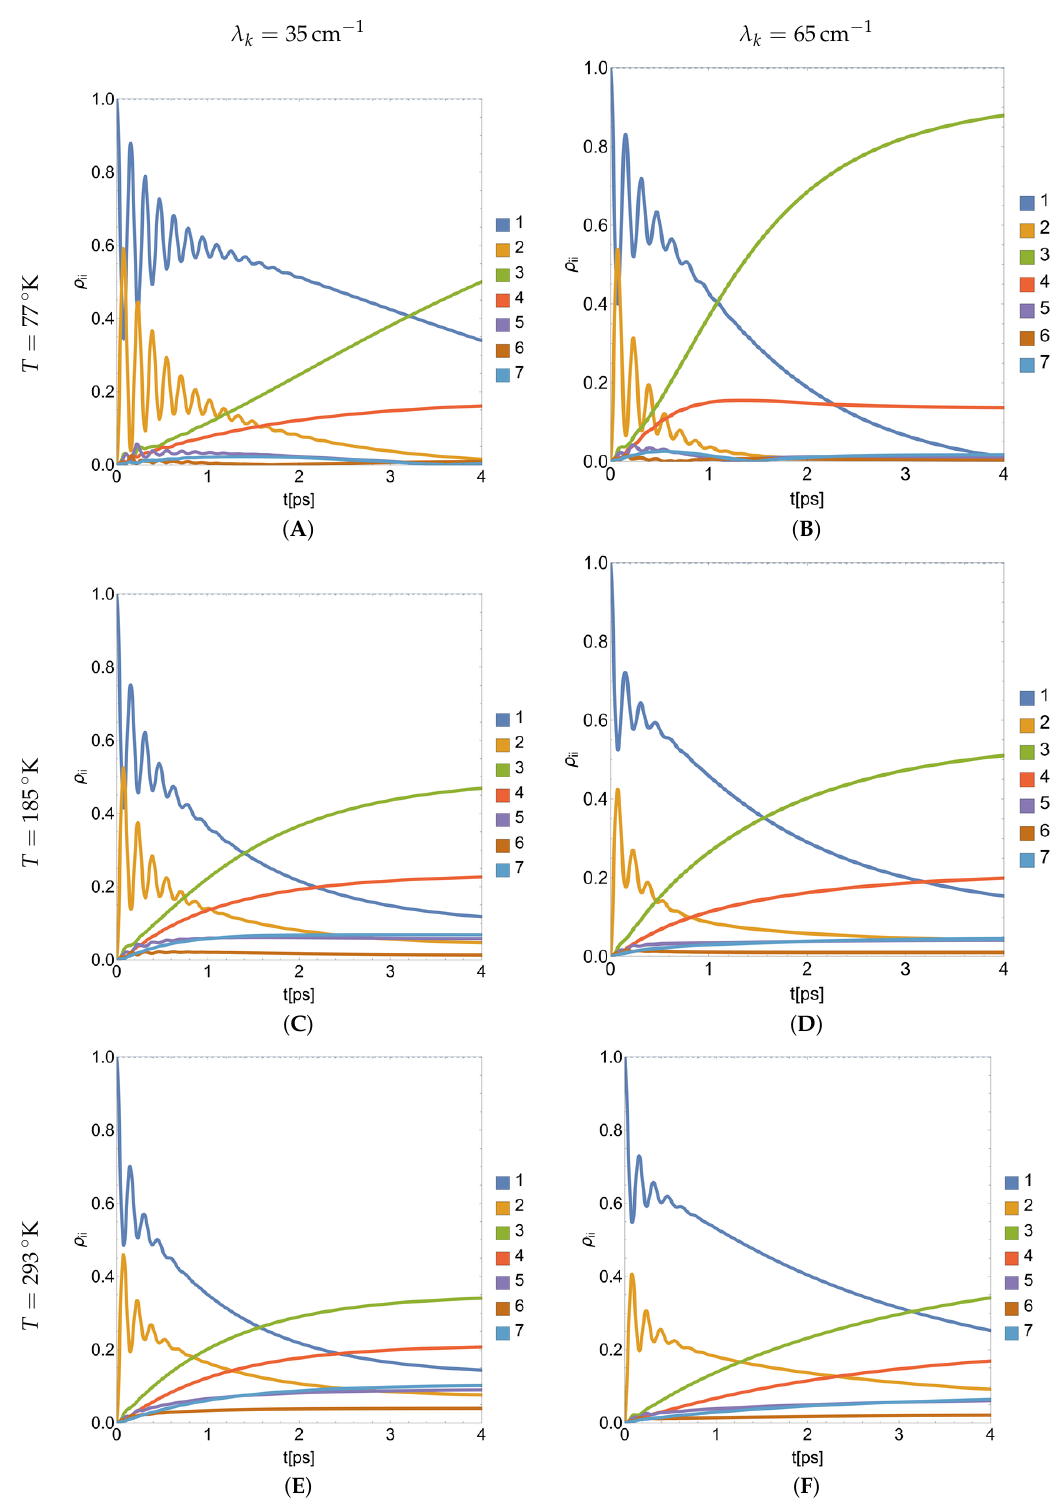
Figure 7. Population evolution in [ 0,4 ] ps for the 7 BChls in the FMO monomer with γ k = 50cm − 1 . λ k = 35,65cm − 1 reported in columns, and T = 77,185,293 ◦ K in rows. Note the differences in the coherence times, transference times and oscillation amplitudes. ( A ) λ k = 35cm − 1 , T = 77 ◦ K; ( B ) λ k = 65cm − 1 , T = 77 ◦ K; ( C ) λ k = 35cm − 1 , T = 185 ◦ K; ( D ) λ k = 65cm − 1 , T = 185 ◦ K; ( E ) λ k = 35cm − 1 , T = 293 ◦ K; ( F ) λ k = 65cm − 1 , T = 293 ◦ K